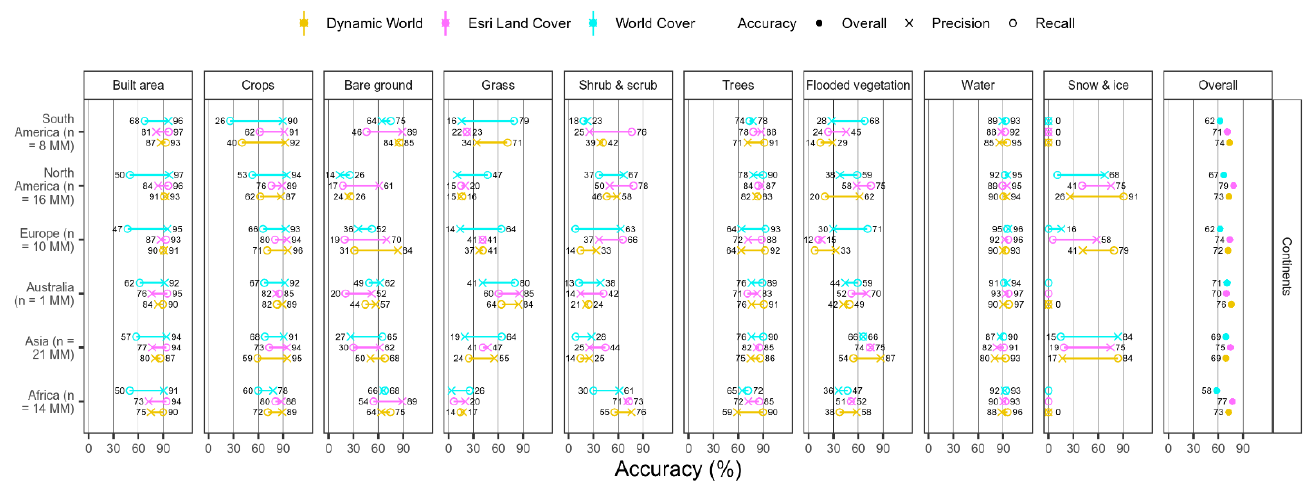
is expressed as precision/user’s, recall/producer’s and overall accuracy based on a confusion matrix, with sample sizes indicated in millions (MM) in parentheses on the y-axis.